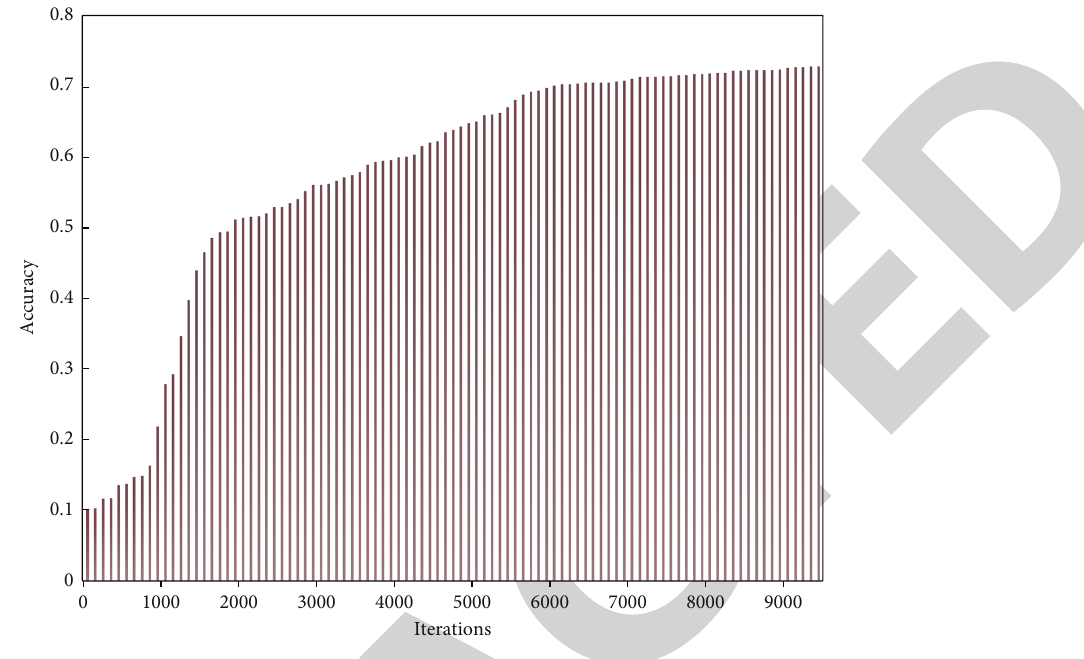
Figure 5: Neural network complex model training accuracy chart.